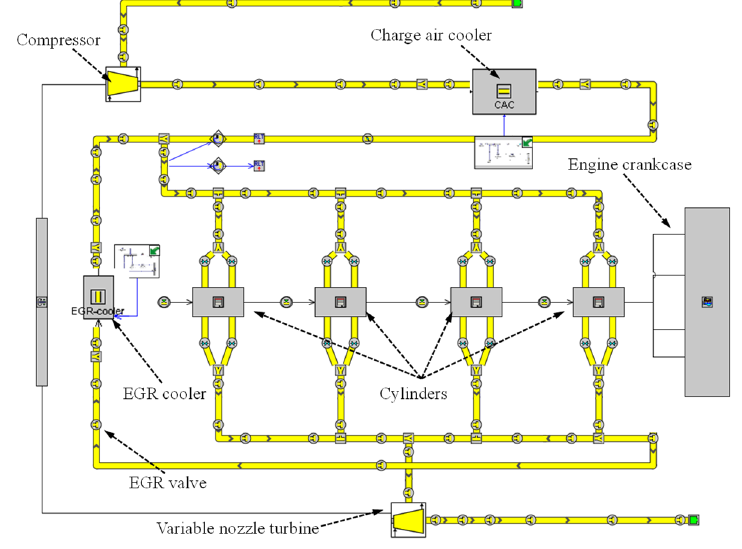
Figure 2. Engine model.